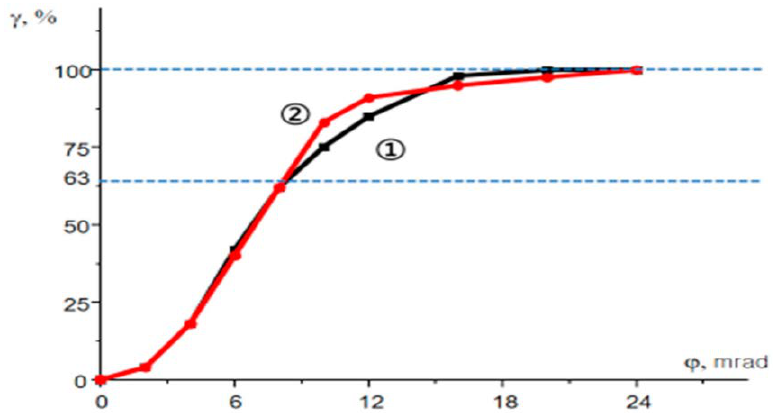
Figure 10. The angular distribution of Ti:Sapphire laser energy for single-mode pumping: 1—W PUMP = 1.0 J/cm 2 ; 2—W PUMP = 1.5 J/cm 2 . Reprinted with permission from ref. [18]. Copyright 2019 © The Optical